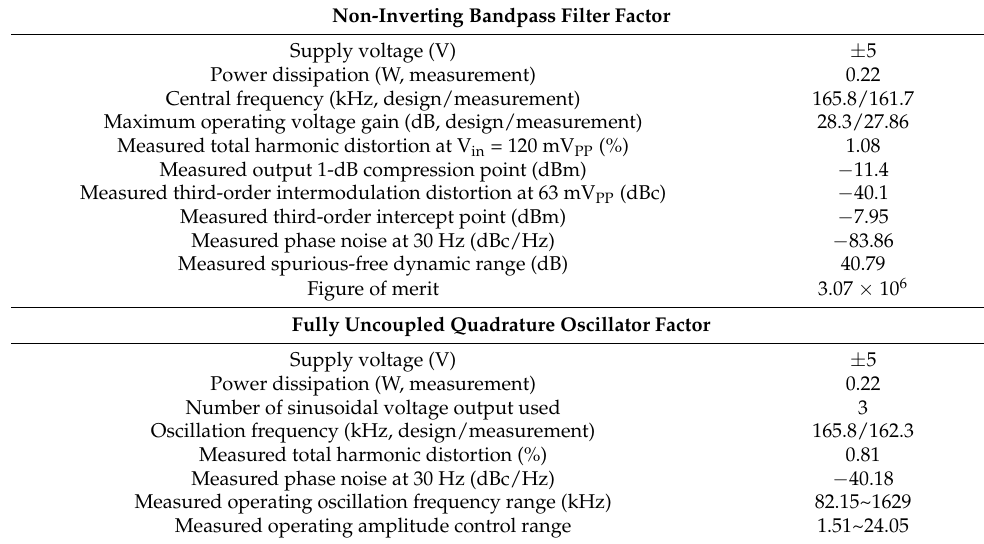
Figure 26. The experimental results of the V o3 voltage gain when R 2 was varied. Table 4. Performance parameters of the performance of the first proposed isomorphic